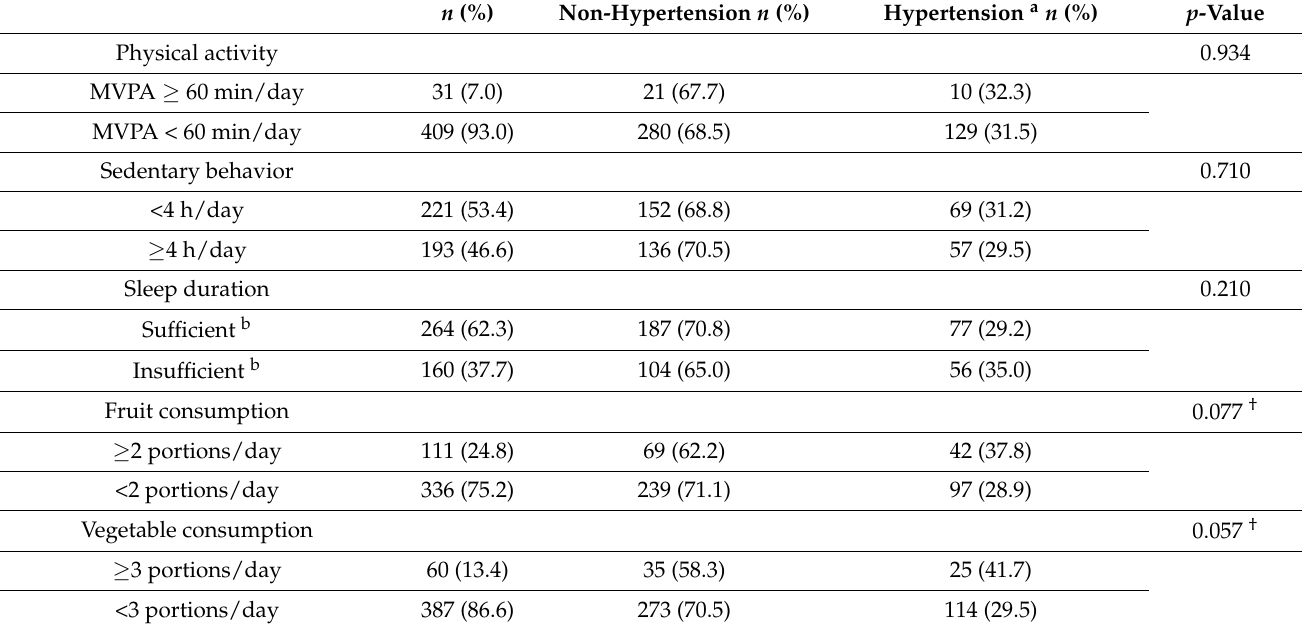
Table 2. Distribution of hypertension by health-related behaviors in children with intellectual